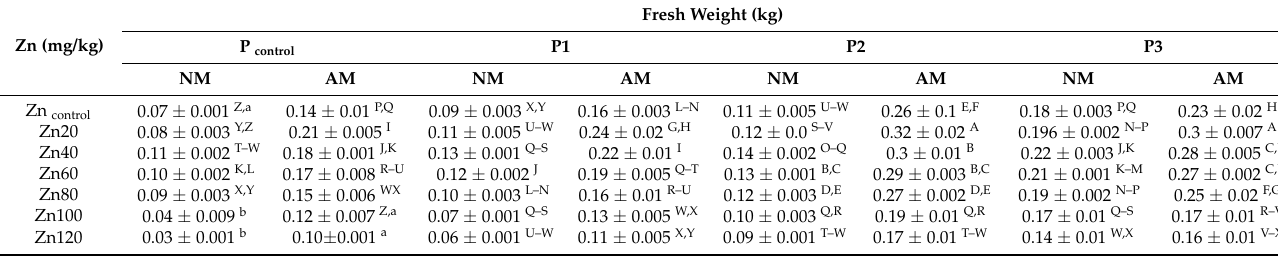
Table 5. Fresh weight (kg) of AMF inoculated (AM) and non-inoculated (NM) plants grown under various P (0 to full recommended dose) and Zn (0–120 mg Zn/kg soil) application